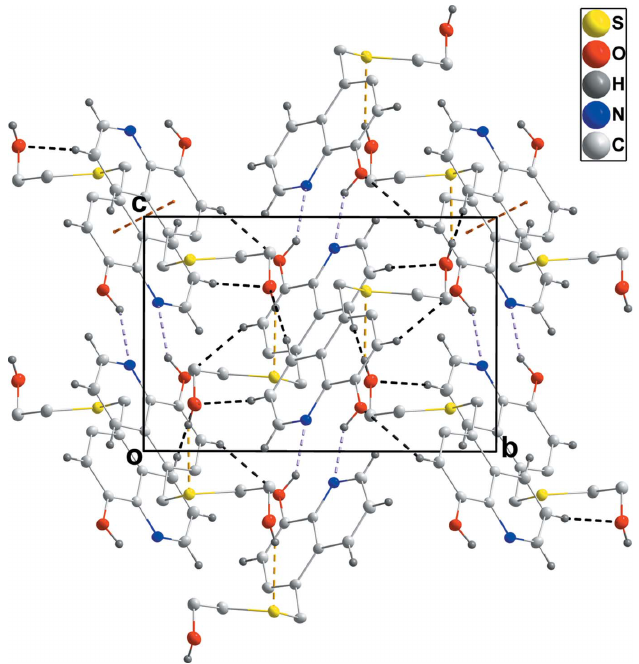
Figure 4 Packing viewed along the a -axis direction with intermolecular inter- actions depicted as in Fig. 2.